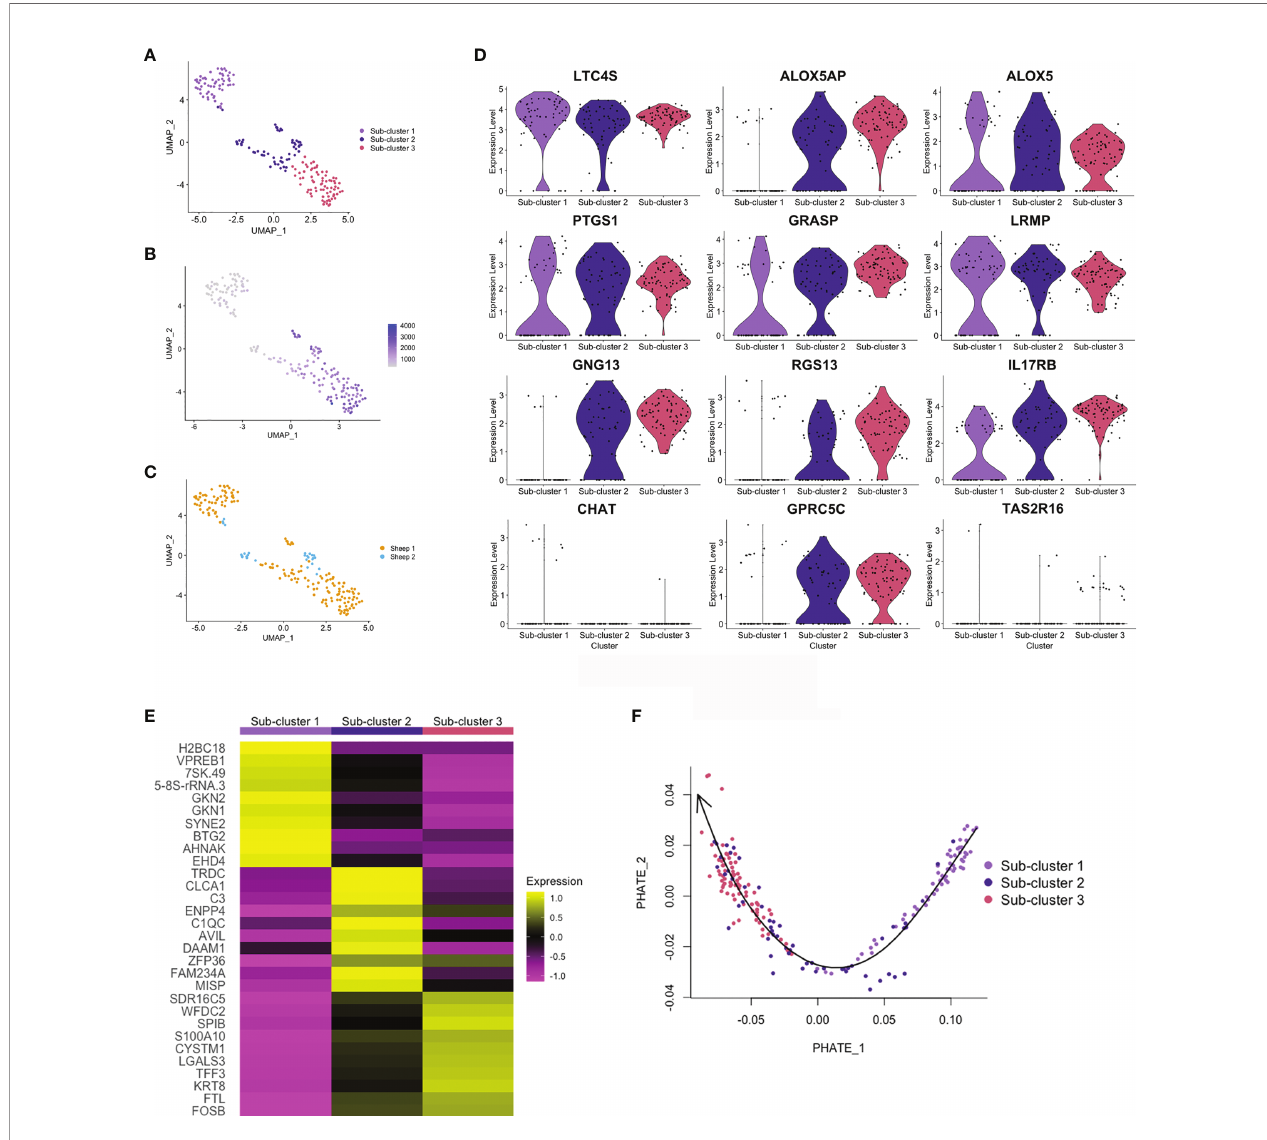
FIGURE 6 | Trajectory analysis of ovine abomasal tuft cell sub-clusters. (A) UMAP plot of ovine tuft cell sub-clusters 1, 2, 3. (B) UMAP plot showing gene expression (UMI) across sub-clusters. (C) UMAP plot of sheep 1 and 2 tuft cell sub-clusters overlapped. (D) Violin plots showing log-normalised expression of selected tuft cell genes across sub-clusters. (E) Heatmap of top 10 marker genes in ovine tuft cell sub-clusters (see Supplementary Table 8 for full gene lists). (F) PHATE (Potential of Heat-diffusion for Af fi nity-based Transition Embedding) plot of sub-cluster gene expression. Arrow on Slingshot line shows suggested direction of lineage, added manually, starting at sub-cluster